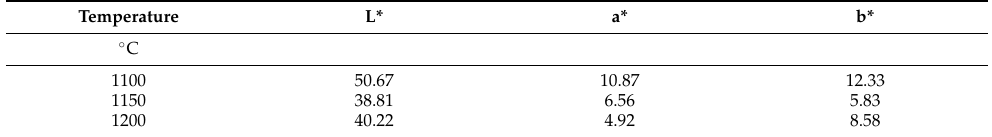
Table 3. Average colour coordinates (L*a*b*) of GS pellets fired at temperatures from 1100 ◦ C to 1200 ◦